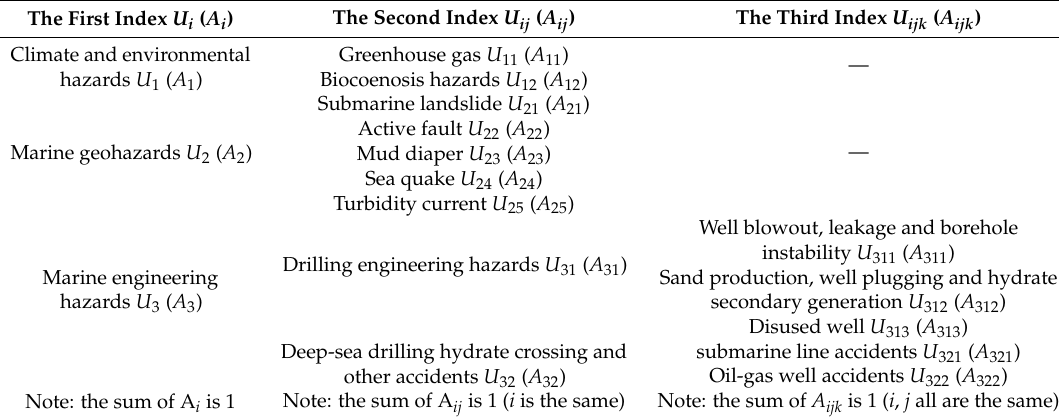
Table 1. Assessment object factors